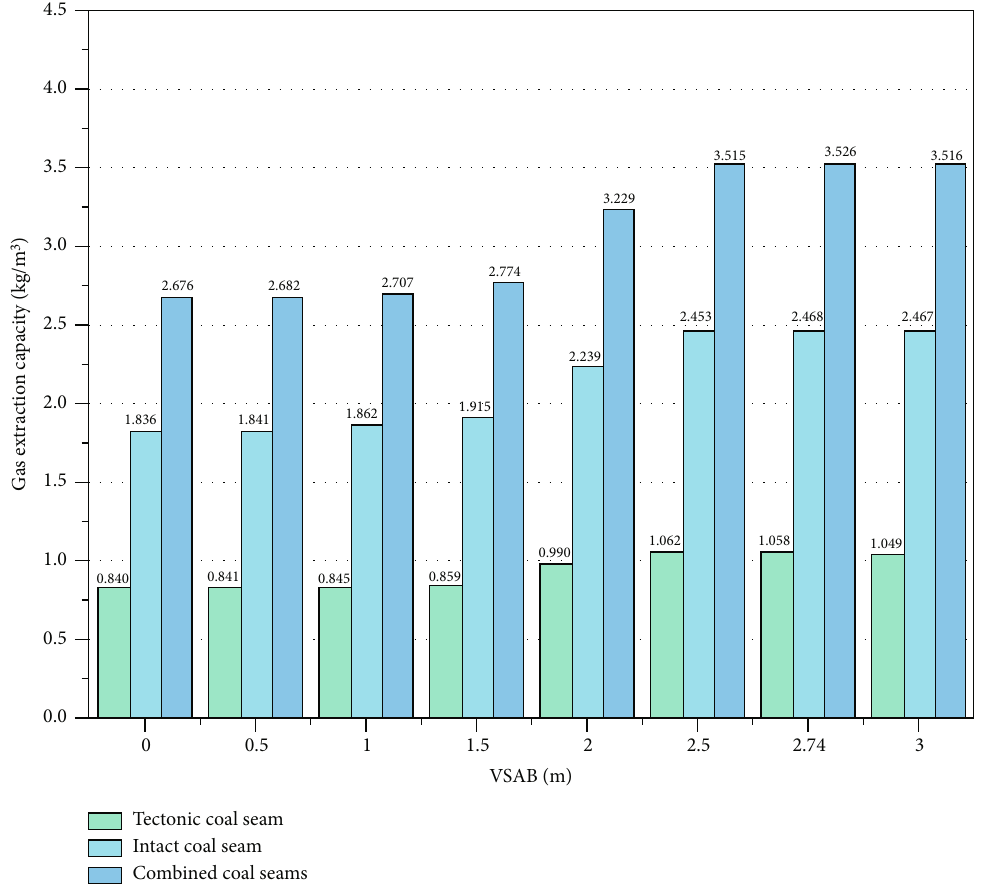
Figure 6: Comparison of extracted gas amount at di ff erent